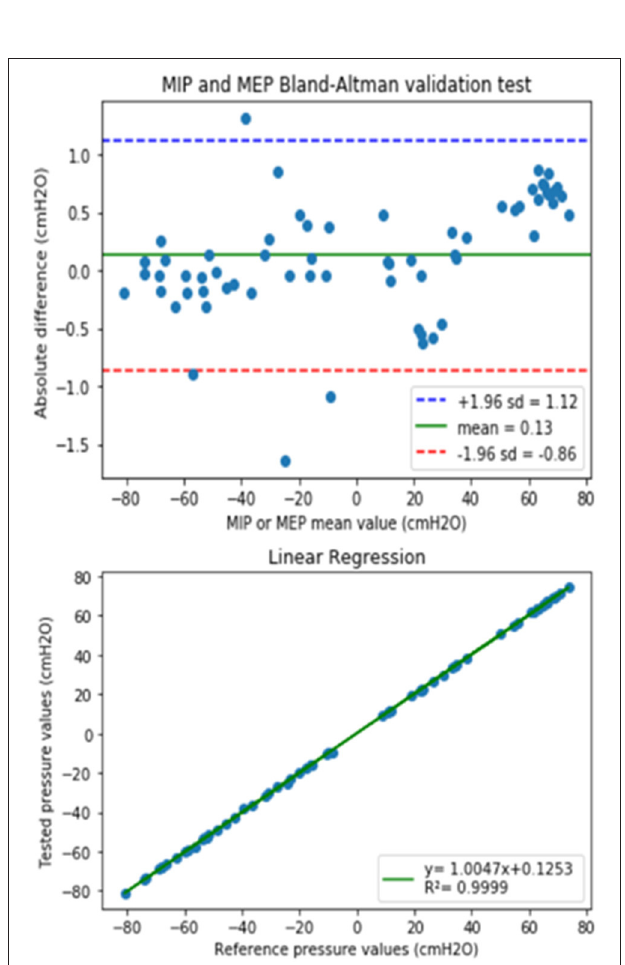
FIGURE 3 | (Top) The Bland–Altman plot showing the difference between values measured by the prototype and the reference equipment, as a function of the measured values for both MIP (negative values) and MEP (positive values). Green line is the prototype bias and blue-red lines indicate the limits of agreement. (Bottom) Linear regression of the values obtained with the developed device and the laboratory